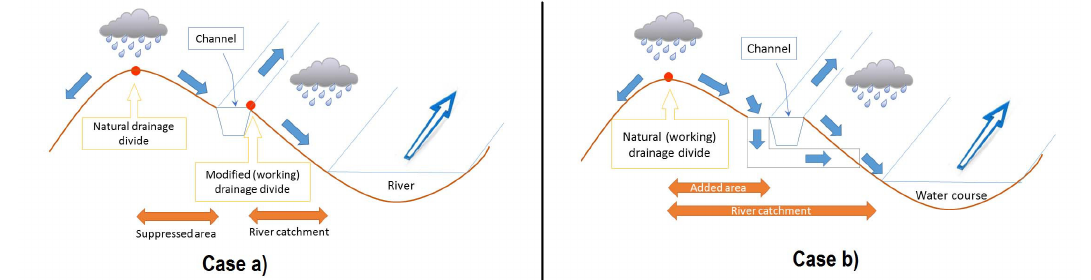
Figure 3. Criteria used to add or suppress catchment area in the proposed